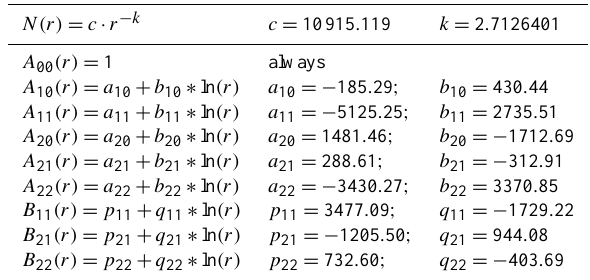
Table 6. Seasonal averaged model fit coefficients.